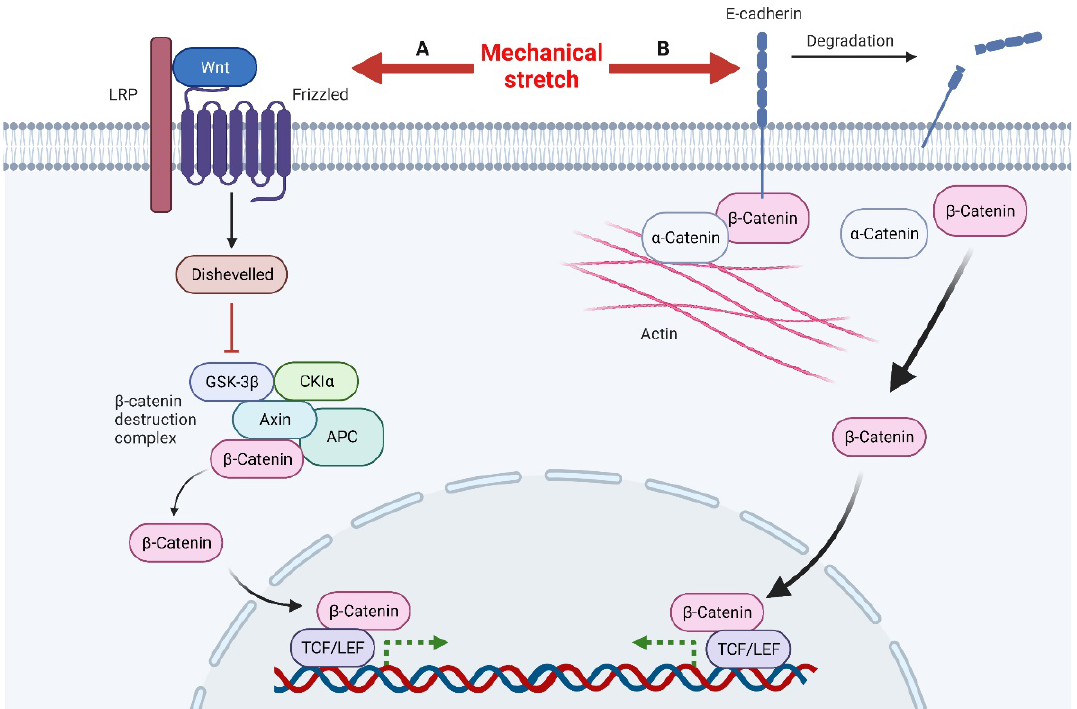
Figure 2. Mechanical stretch induces β -catenin activity through Wnt-protein-dependent and -independent ways. A, Mechanical stretch up-regulates Wnt proteins to activate Wnt signals. After Disheveled is recruited to inactivate the β -catenin destruction complex, this leads to the accumulation of β -catenin in the nucleus. β -catenin combines with the transcription factor TCF/LEF to regulate the transcription of target genes. B, Mechanical stimulation can also lead to the degradation of E-cadherin, releasing β -catenin in the E-cadherin binding pool, resulting in the accumulation of β -catenin in the nucleus and ultimately regulating the transcription of target genes.